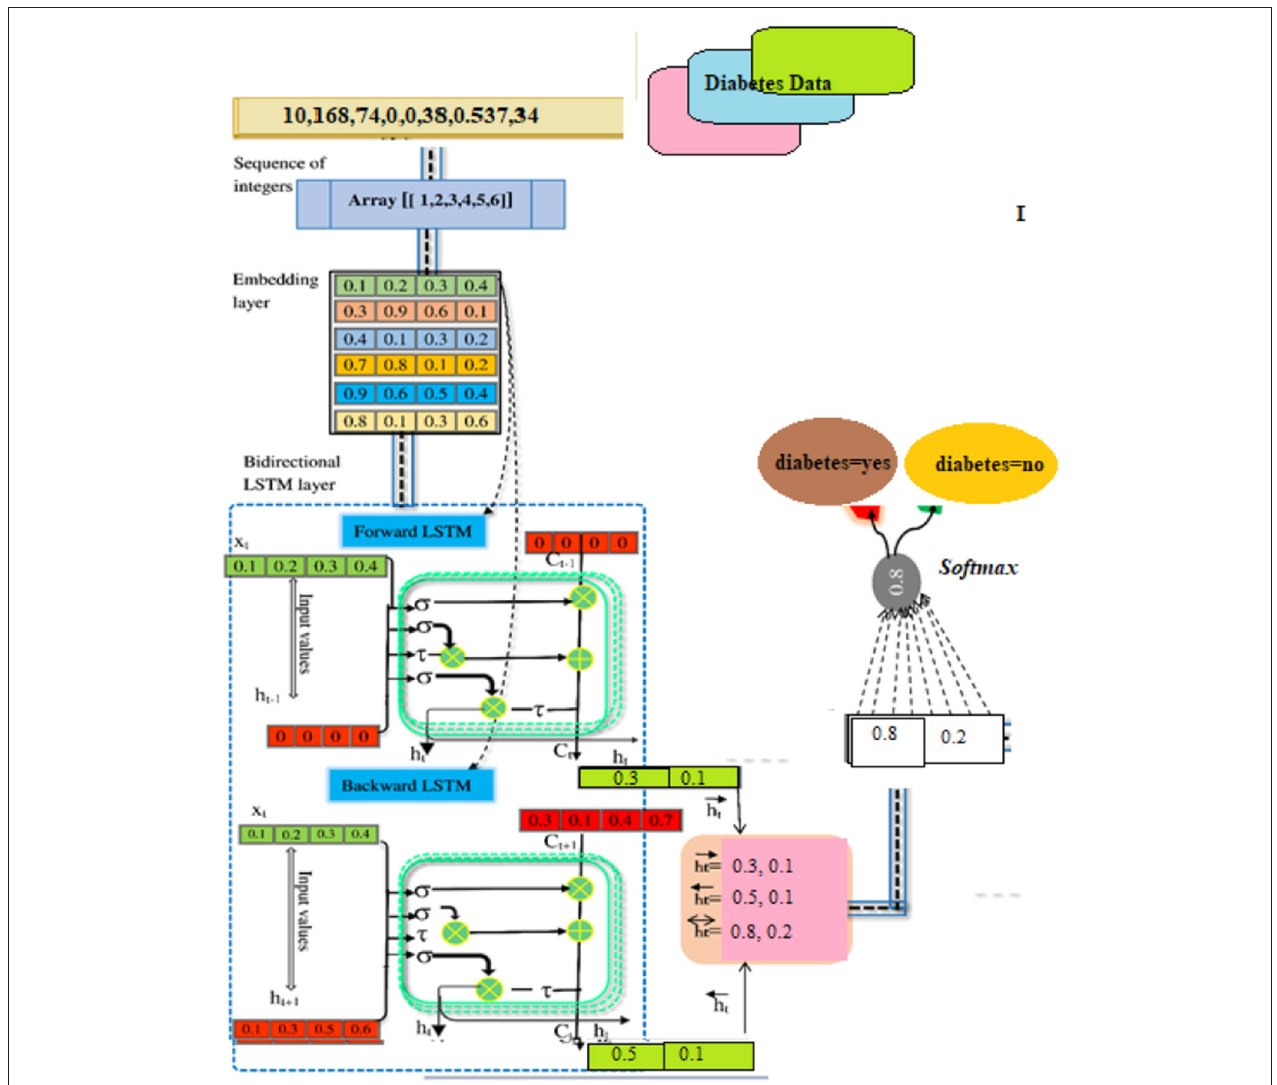
FIGURE 3 | BILSTM-based for diabetes prediction system.